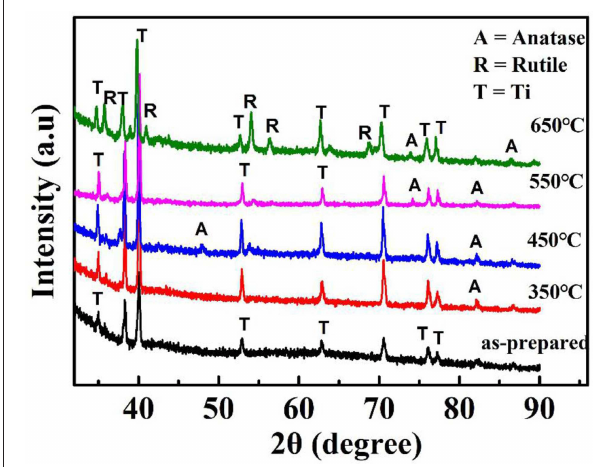
Frontiers in Materials |